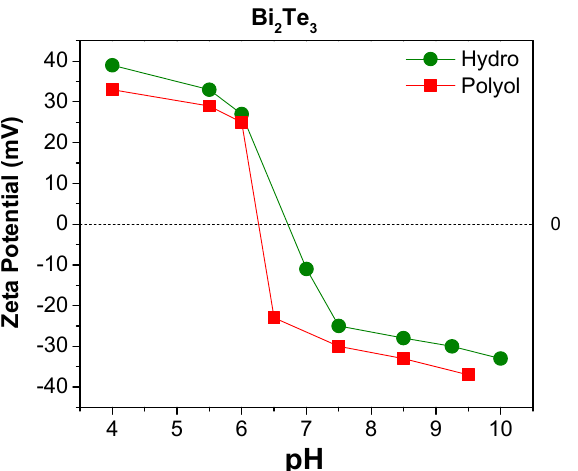
Figure 4. ξ -potential analysis of as-made Bi 2 Te 3 samples synthesized through MW-assisted hydrothermal, and polyol routes.